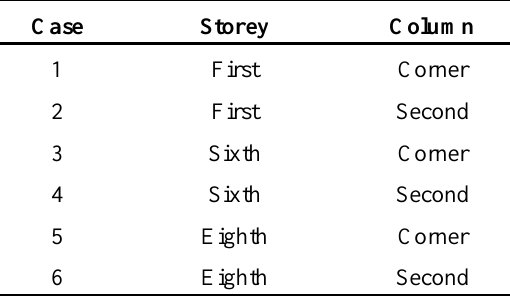
Table 3. Column removal Cases in 10-storey